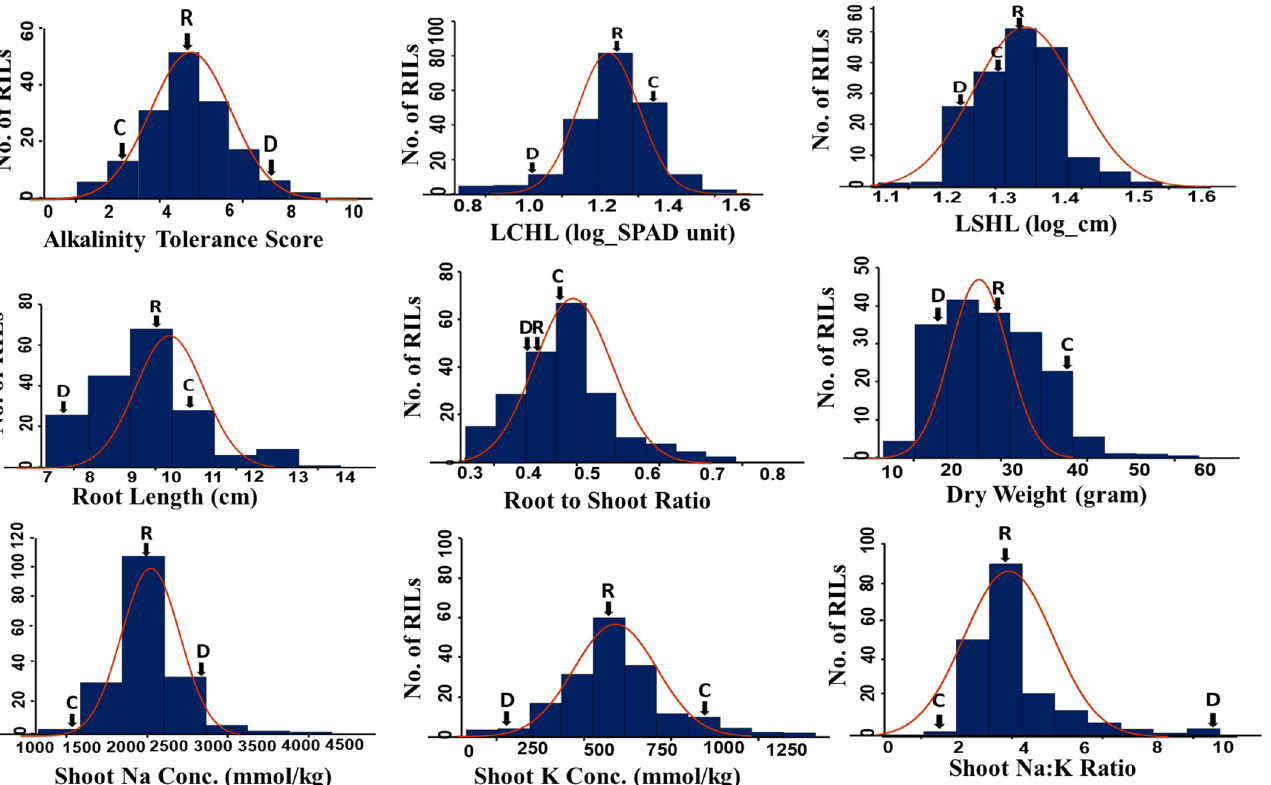
Figure 1. Frequency distribution of various morphological and physiological traits of Cocodrie × Dular RILs for alkalinity tolerance at the seedling stage with arrowheads indicating the trait means of Cocodrie (C), Dular (D), and RIL population (R). LCHL-log chlorophyll content; LSHL-log shoot length.